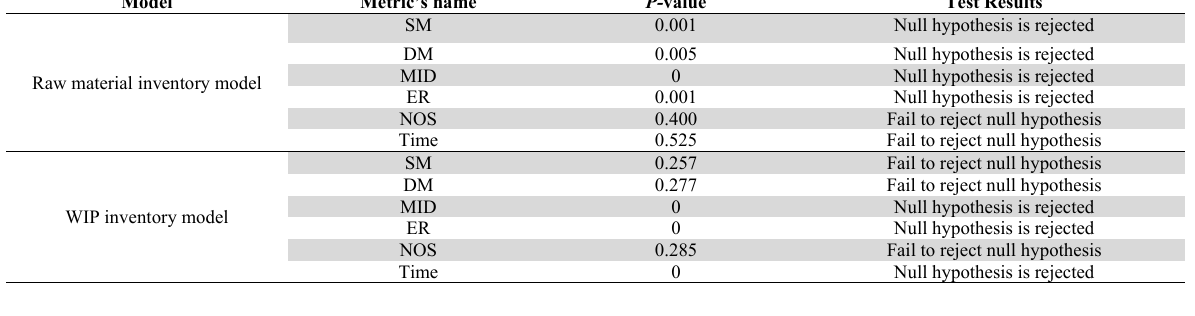
ANOVA comparison results with P -values